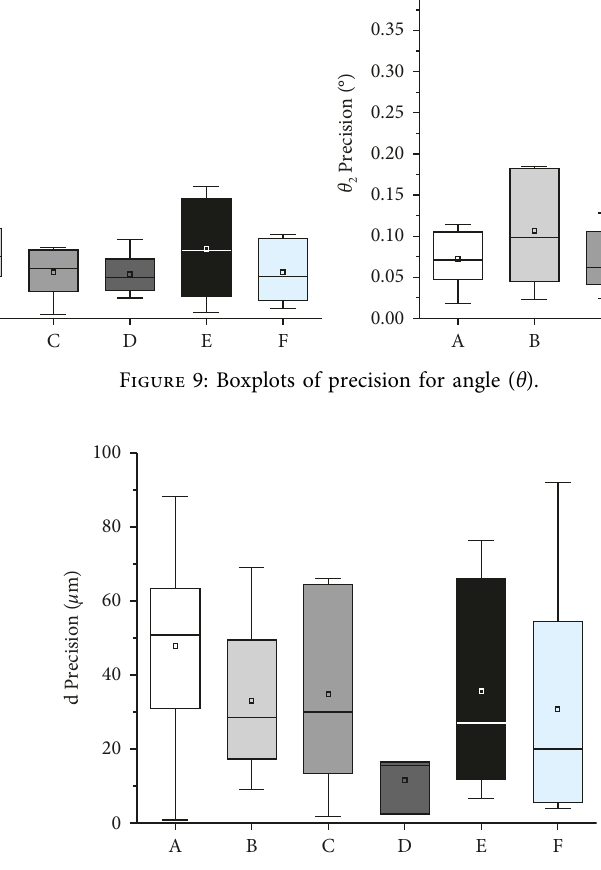
Figure 10: Boxplots of precision for distance ( d ). standard deviation (SD) of the crown-and bridge models of resins having different values. ±